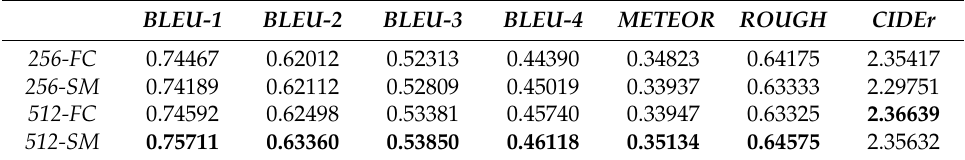
Table 4. Results with different s attr on